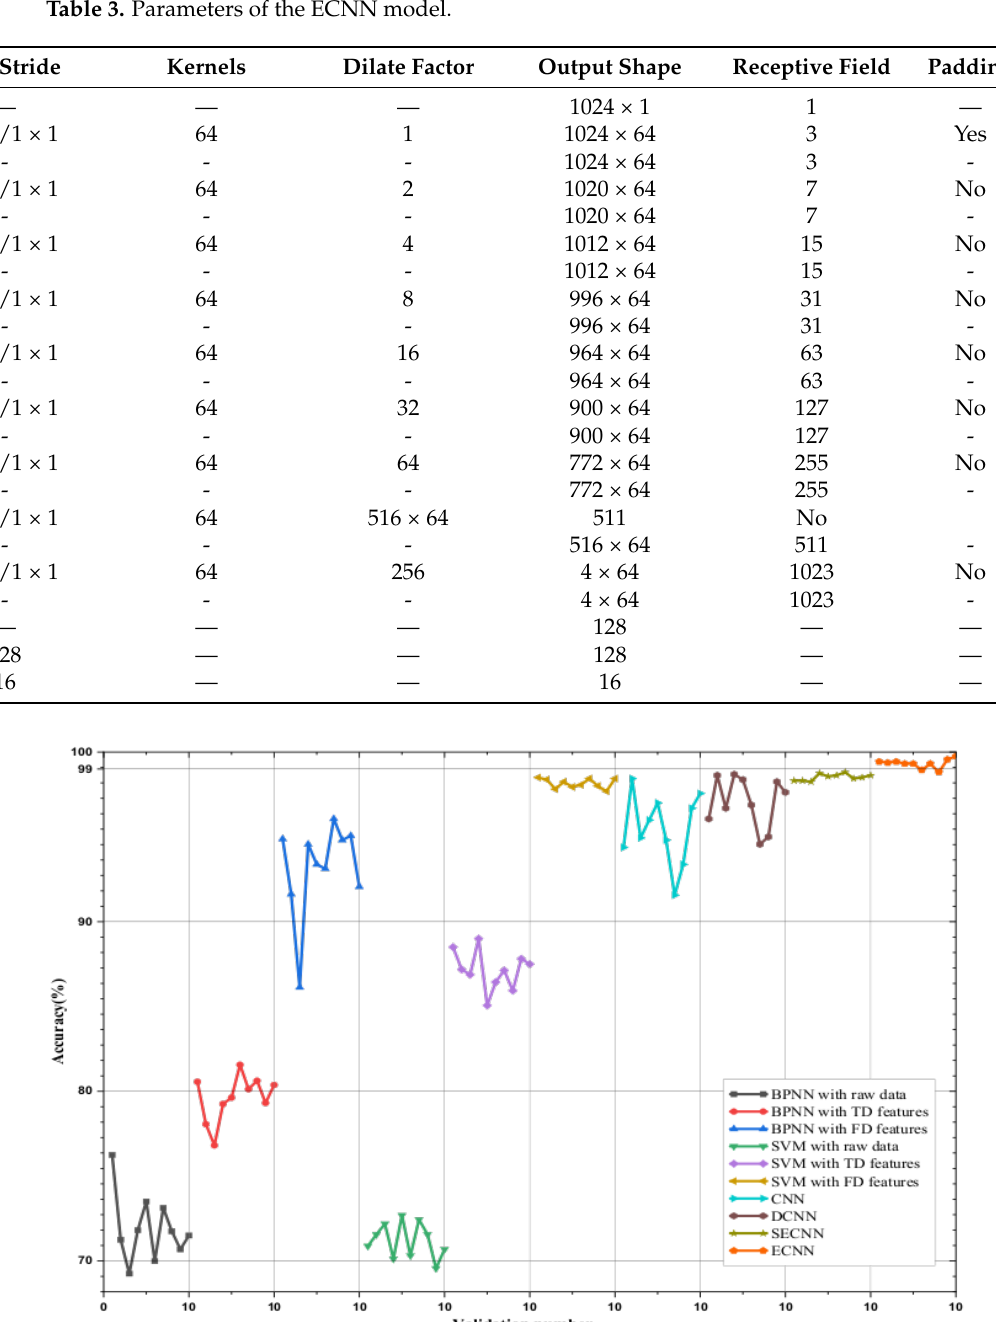
Table 3. Parameters of the ECNN model.